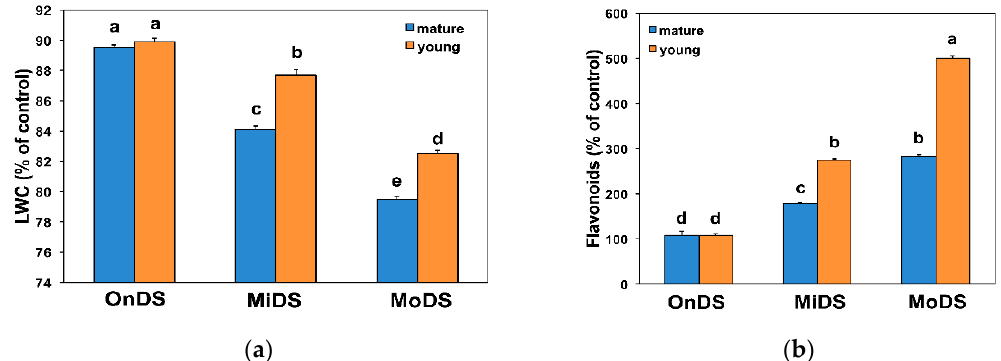
Figure 1. The relative leaf water content ( a ) and the flavonoid content ( b ) expressed as percentage of control (well-watered plants), in A. thaliana young and mature leaves at the onset of drought stress (OnDS), at mild drought stress (MiDS) and at moderate drought stress (MoDS). Error bars represent ± standard error of the mean (n = 5–6). Bars with different lowercase letters are significantly different at p < 0.05.